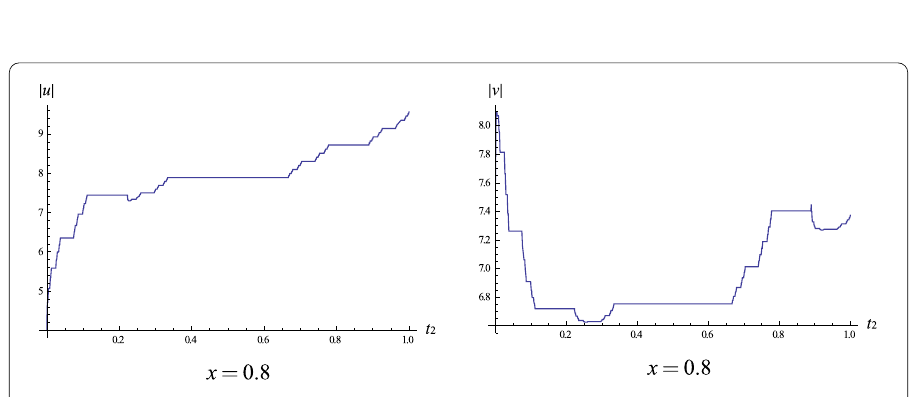
Figure 8 Profiles along the t 2 axis of two-fractal solutions (147) and (148) with α = ln2/ln3.